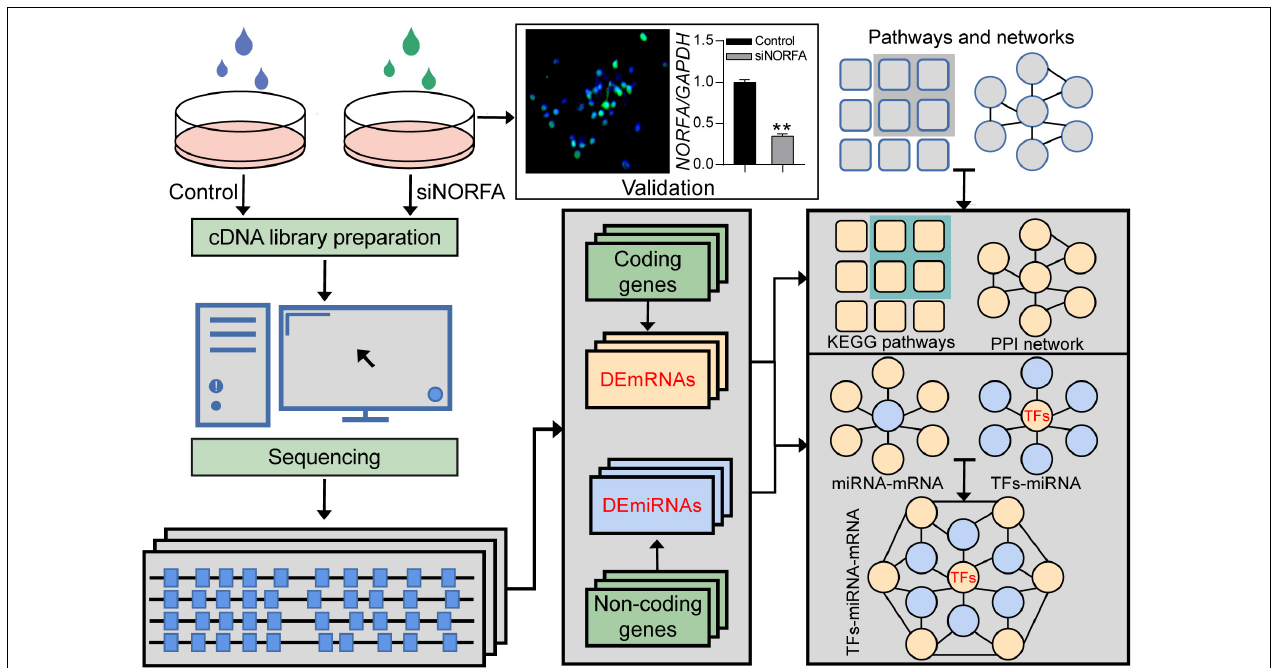
FIGURE 1 | The strategy for identification of NORFA -mediated TF–miRNA–mRNA regulatory network in porcine GCs. Flow diagram representing the strategy for DEmRNAs and DEmiRNAs detection by using RNA-seq and the subsequent assessment of their function as well as the construction of the regulatory network in NORFA -inhibited porcine